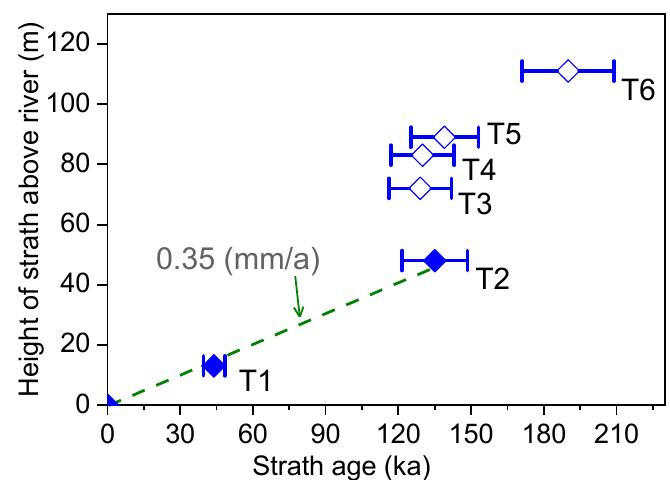
Figure 8. Plot of elevation of strath above the modern river level as a function of strath ages. The error of 10% was assumed for the inferred strath ages. The OSL ages of the T3 to T6 terraces marked as open diamonds are obviously underestimated (see text for details). The dash regression line represents a time-averaged incision rate 0.35 mm/a for the past 135 ka. The elevation of terrace strath above a modern river level is often used to calculate the mean bedrock river incision rates [78,79], which in some cases can be used as a proxy for rock-uplift rates [1]. Although Figure 8 shows that the ages of the T3–T6 terraces were underestimated, the strath heights and ages of the T1 and T2 terraces can be used for calculating the average incision rate for the past 135 ka. The regression of the strath ages versus the elevations for the T1 and T2 terraces above the modern river level defines a mean incision rate of 0.35 mm/a for the past 135 ka (Figure 8). The incision rate for the past 44 ka was calculated to be about 0.35 mm/a by dividing the elevation by the age of the T1 terrace. The incision rate of 0.35 mm/a in this study is similar to the rates of 0.34 mm/a for the past 108 ka in the Heiyukou area [20] and 0.35 mm/ka for the past 70 ka in the Hukou area [19] (Figure 1a). This can be explained by the fact that the Ordos Plateau, an uplifted basin, behaves as a rigid block (Figure 1a). On the other hand, the incision rate also represents the uplift rates of the block.